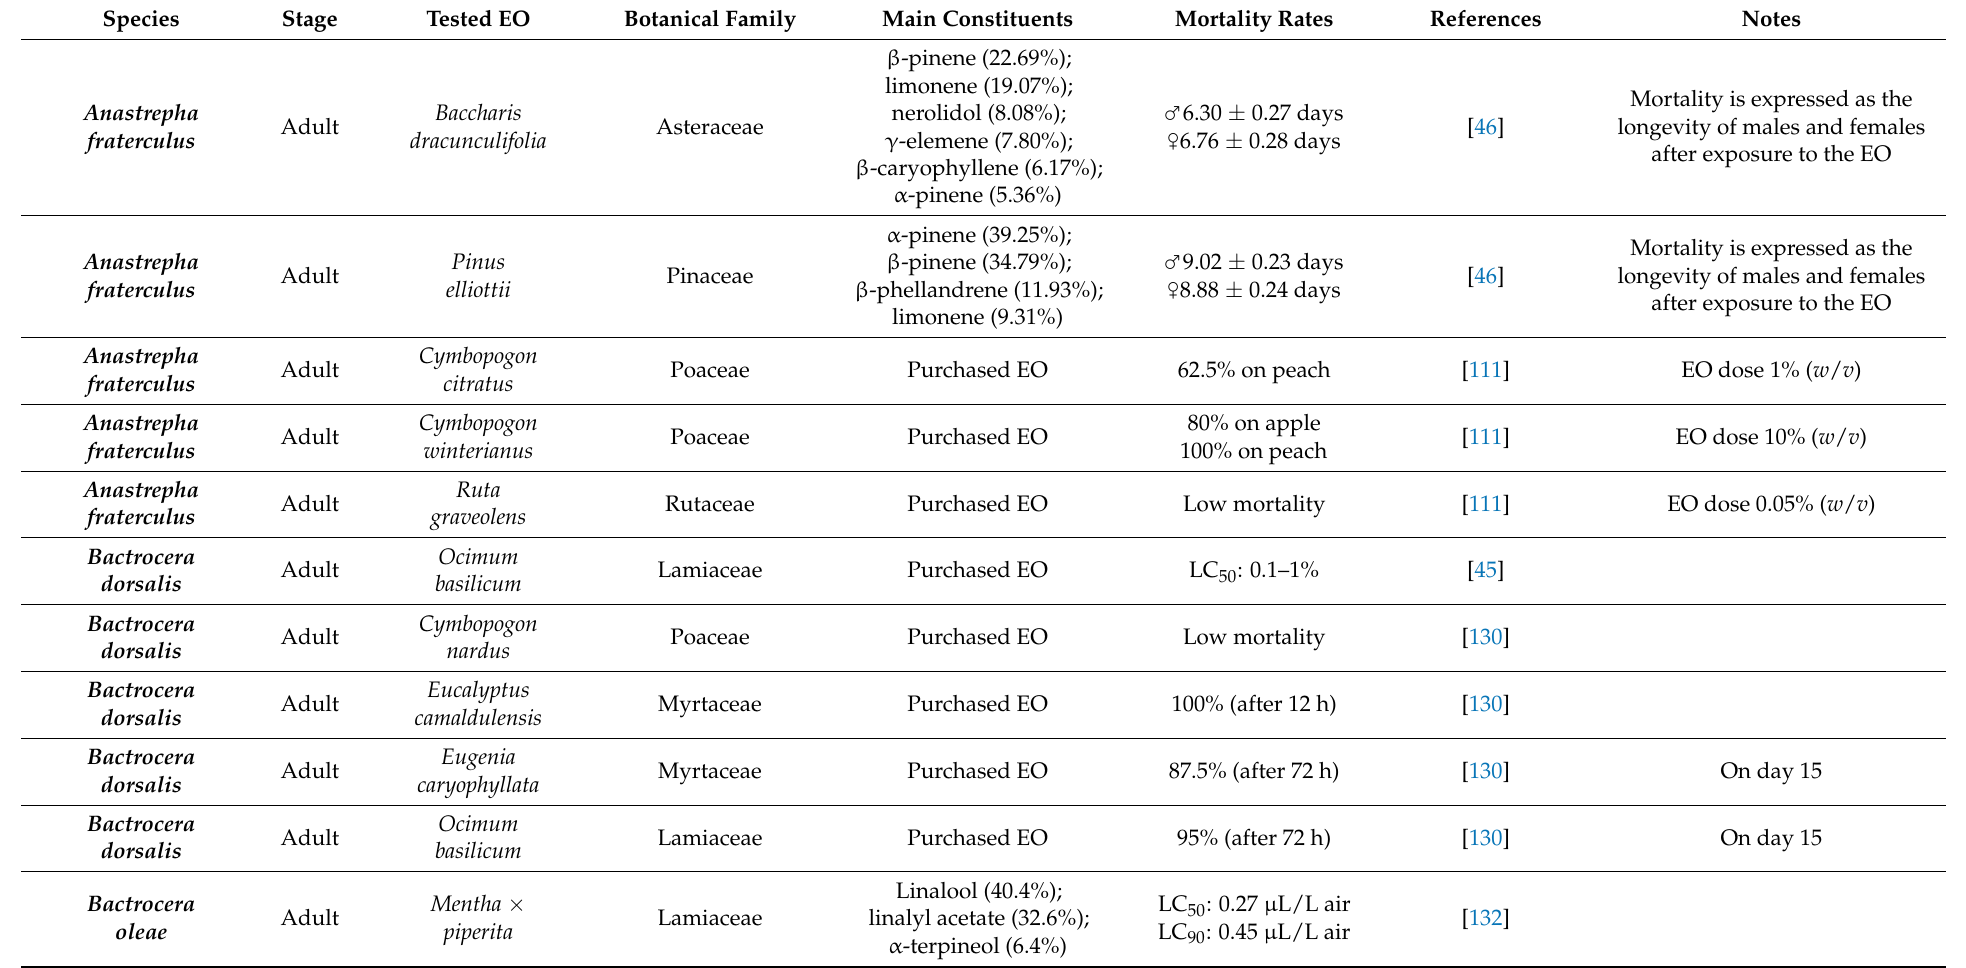
Table 2. Essential oils (EOs) were examined for fumigant activity against immature and adult stages of Tephritidae flies. In addition to mortality, the percentage of main compounds of tested EOs is